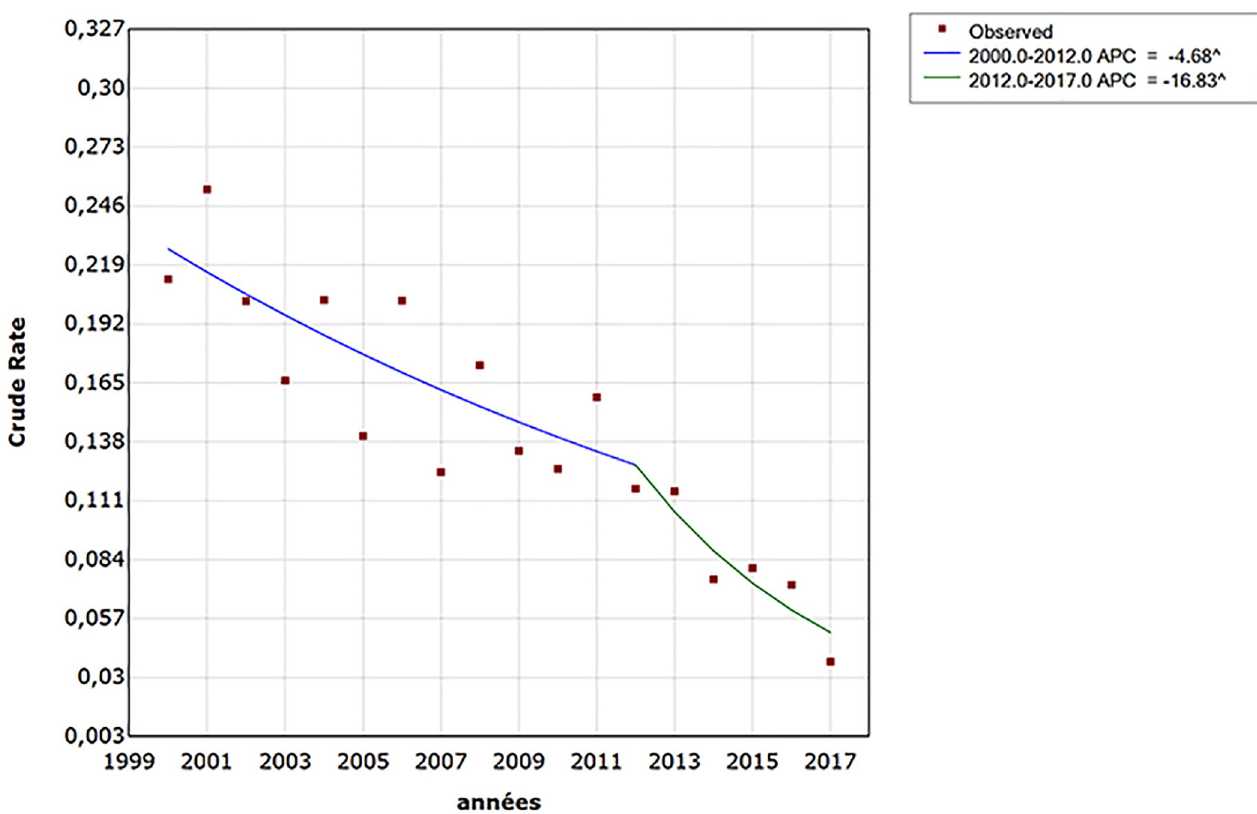
Fig 2. Observed and analyzed trend of leprosy detection in Morocco between 2000 and 2017. APC: Annual percent change. ^difference statistically significant (p < 0.05).